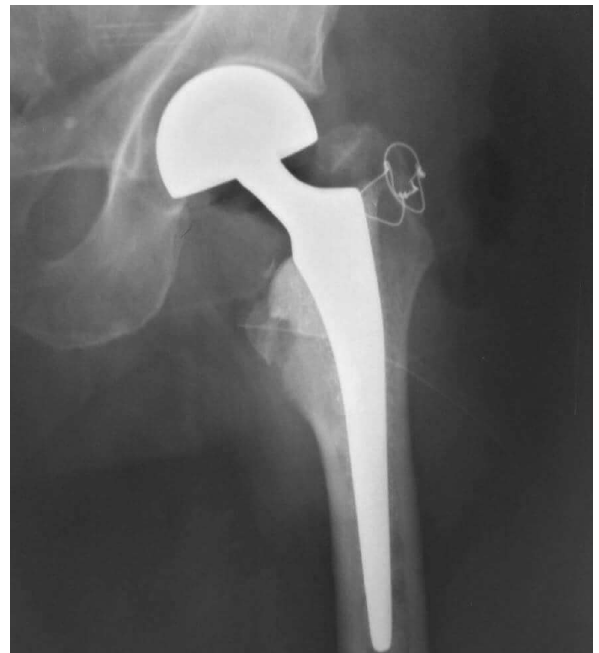
Figure 4. Post operation